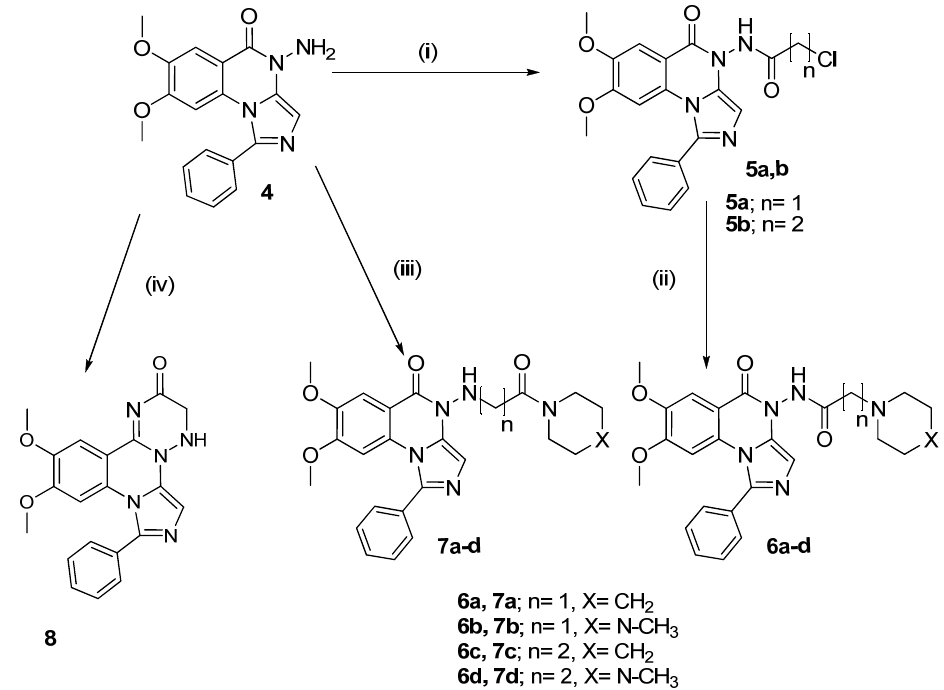
Scheme 2. Synthesis of the target compounds 5 – 8